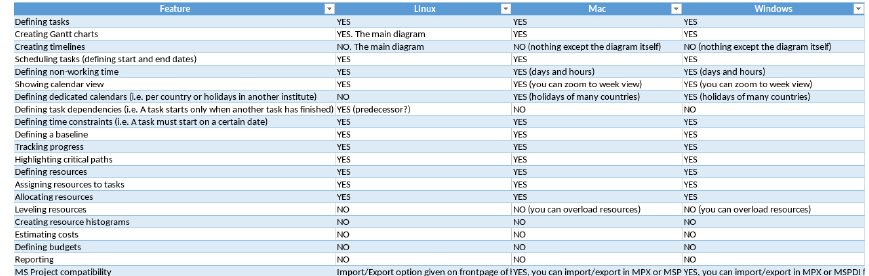
Figure 4. Market Analysis - Example of feature analysis